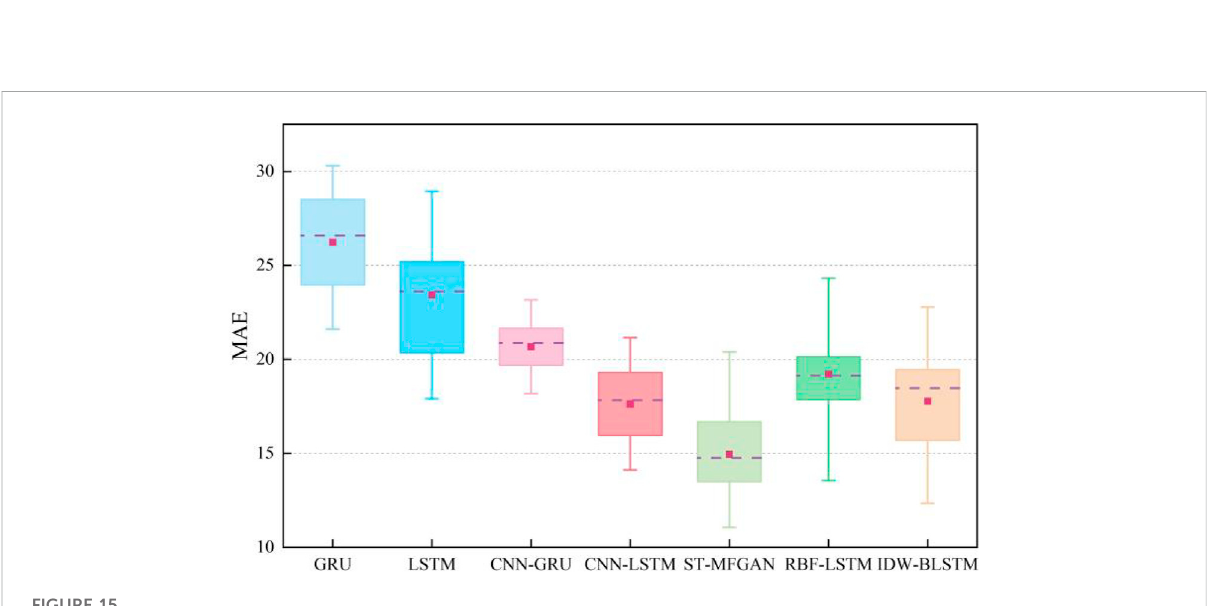
FIGURE 15 MAE of different methods on the test